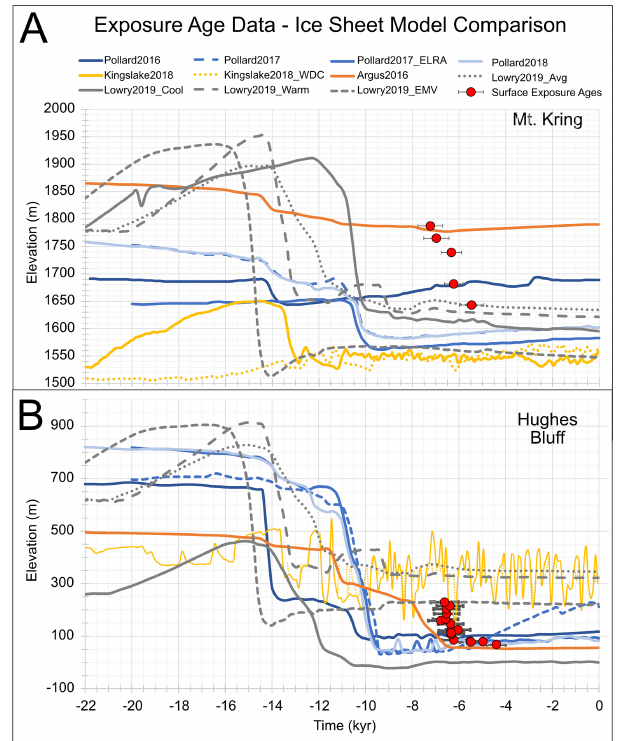
Figure 8. Surface exposure age data – ice sheet model compar- isons for (a) Mt Kring and (b) Hughes Bluff. Ice sheet modelled re- construction data and supporting information from http://dmc.ice-d. org/ and Lowry et al. (2019). Kingslake2018_WDC uses WAIS Di- vide accumulation forcing, and Lowry2019_EMV is a model in which enhanced mantle viscosity is